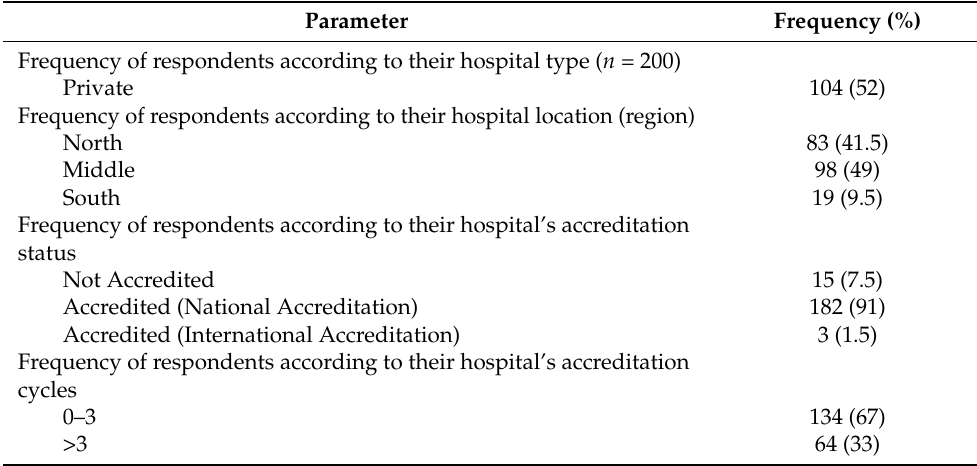
Table 2. Participants’ hospital characteristics (the distribution was based on participants’ responses).